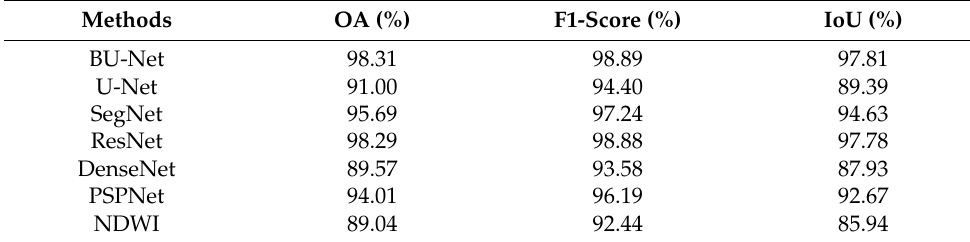
Table 4. OA, F1-score and IoU of different networks.